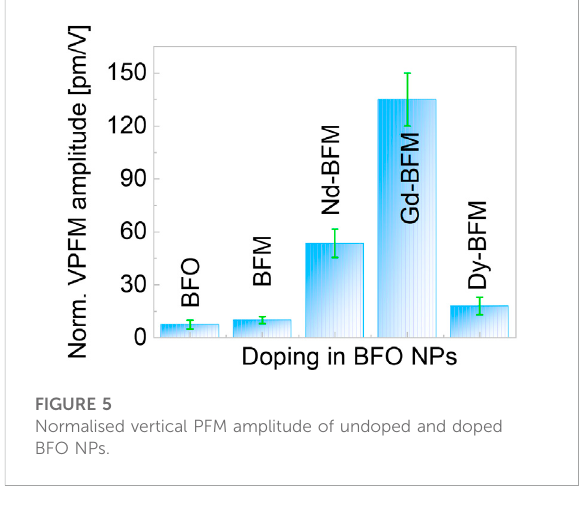
FIGURE 5 Normalised vertical PFM amplitude of undoped and doped BFO NPs.